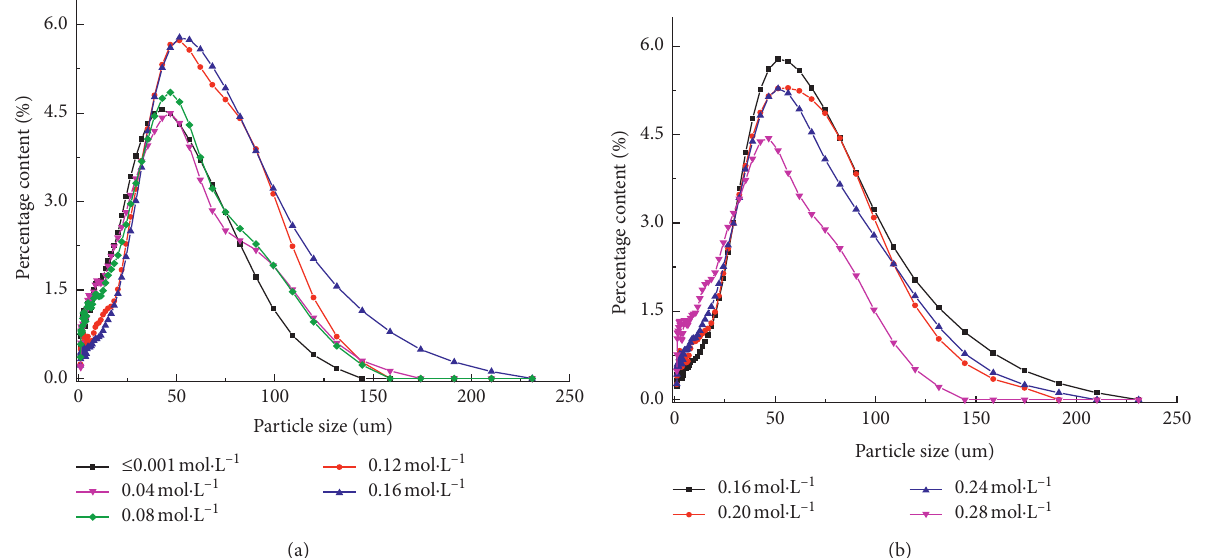
Figure 8: Grading of ore particles. (a) ≤ 0.001–0.16 mol · L − 1 (NH